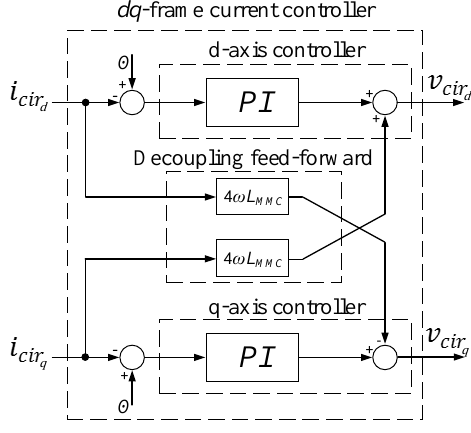
Figure 7. The dq -frame circulating current control scheme.